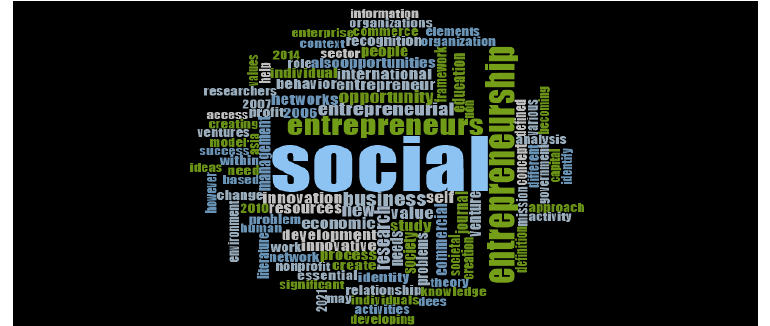
Figure 4.4. Word Cloud extracted from Nvivo